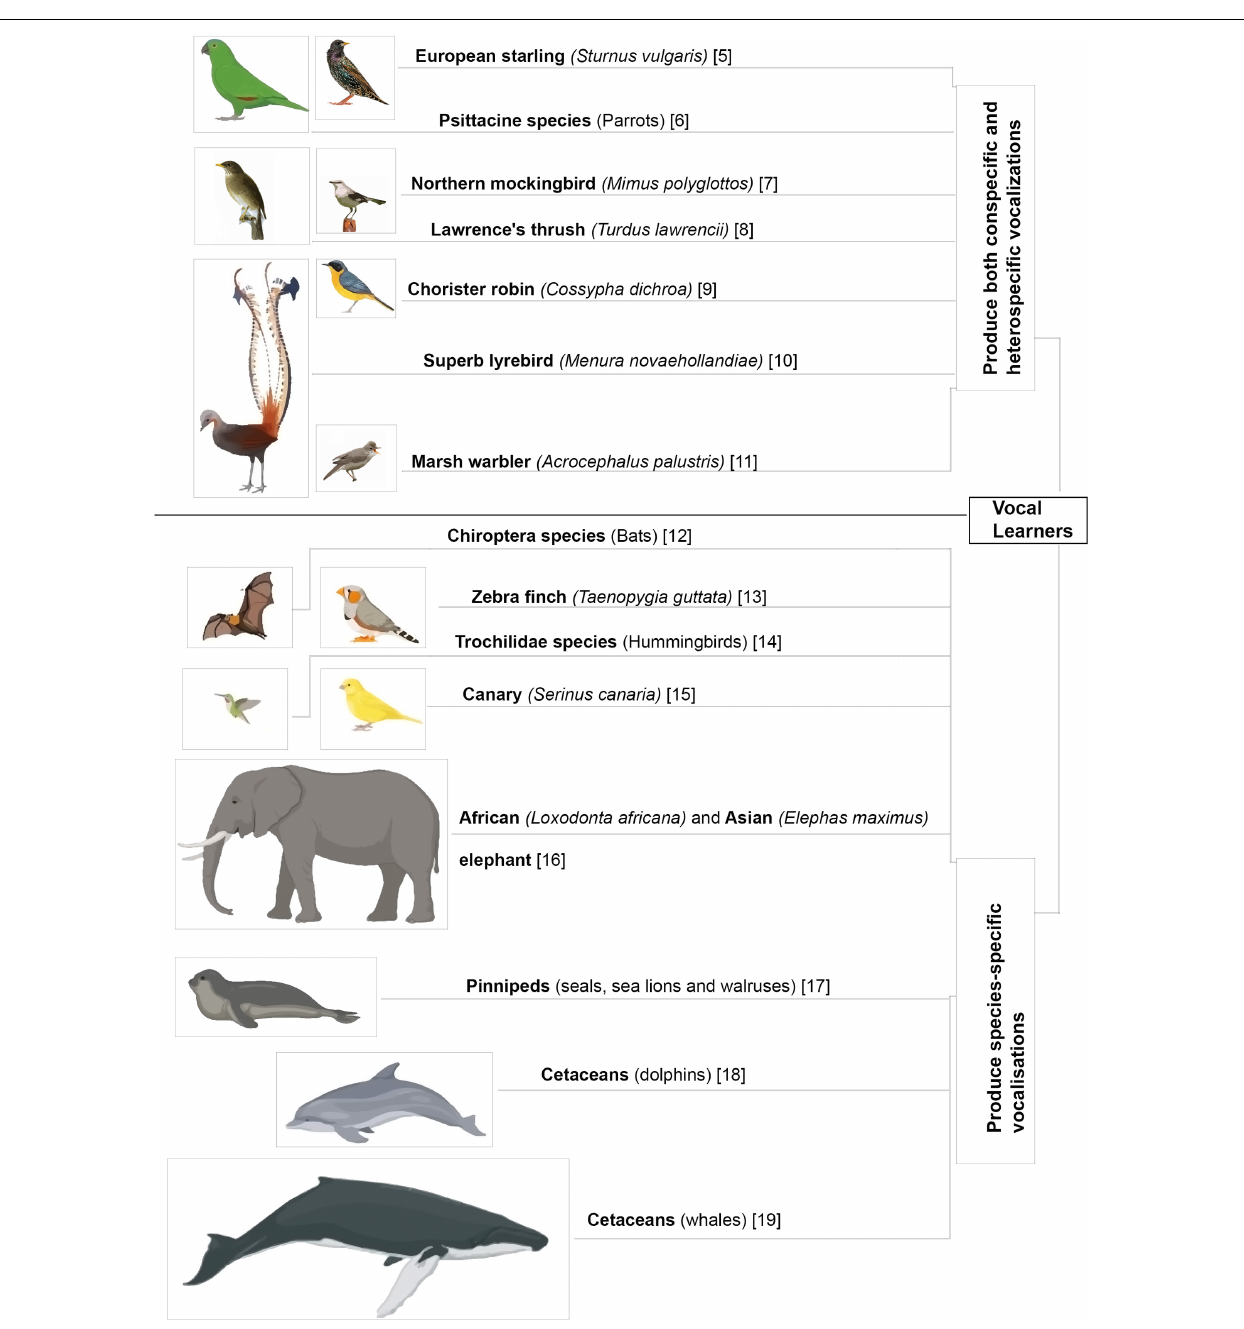
song” (Immelmann, 1969; Marler and Peters, 1982; Böhner, 1990; Zann,